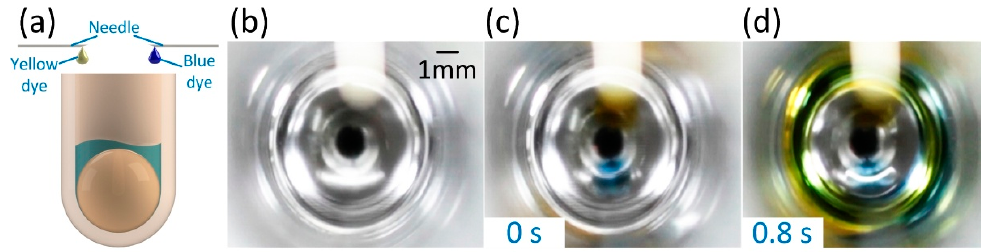
Figure 4. Mixer based on a self-rotating LMD. ( a ) Schematic illustration of the mixing setup. ( b–d ) Continuous captures of mixing two drops of dye.